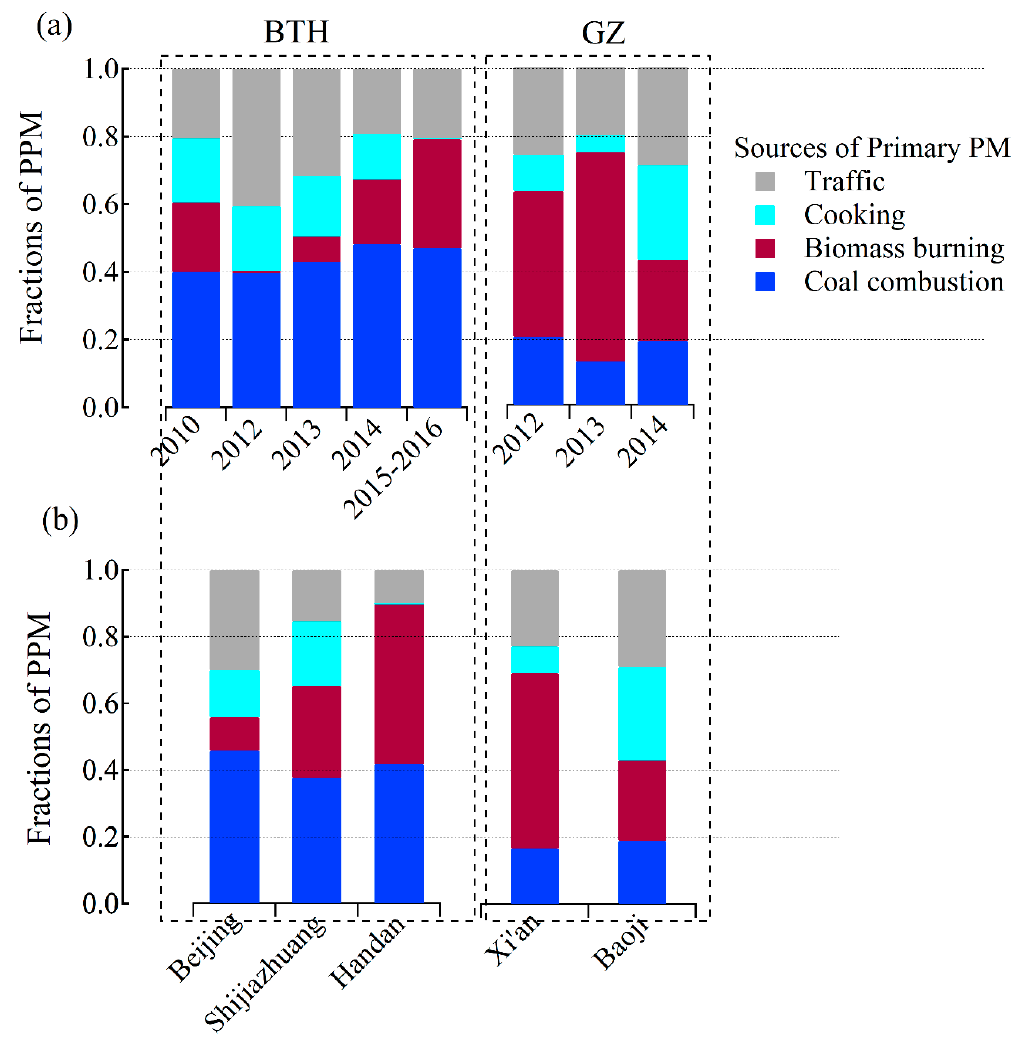
Figure 6. Relative contributions of primary sources to the primary particulate matter (PPM, including primary OA, chloride, and BC) in ( a ) different years and ( b ) different cities of northern China.